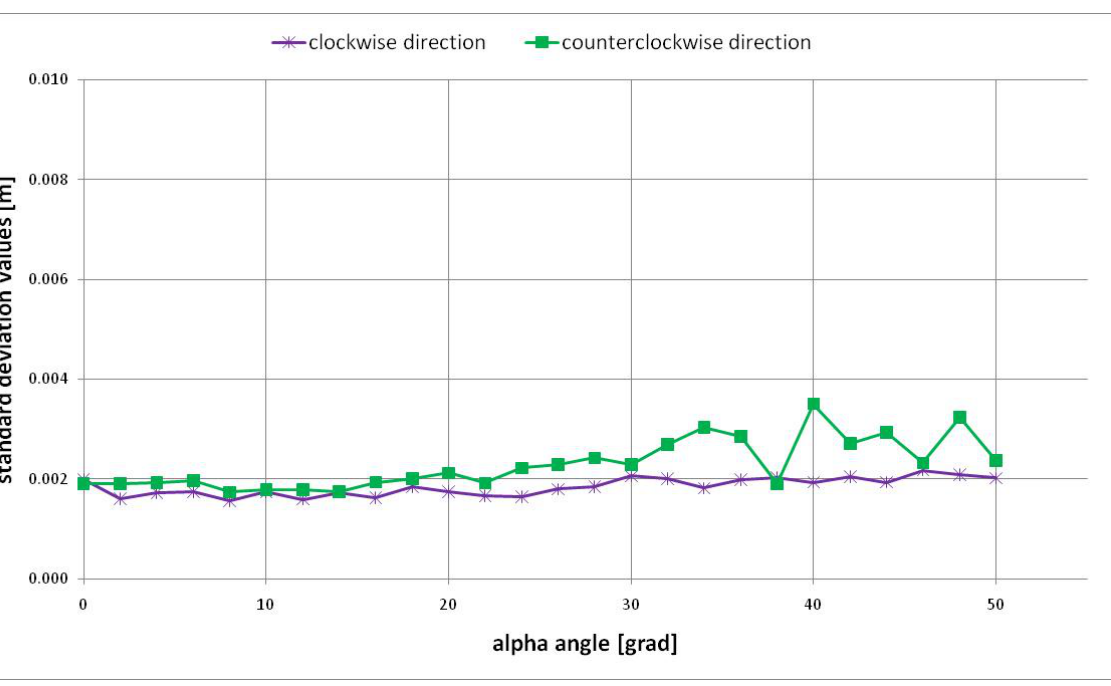
Figure 11. Standard deviation values of the differences between range image and estimated reference